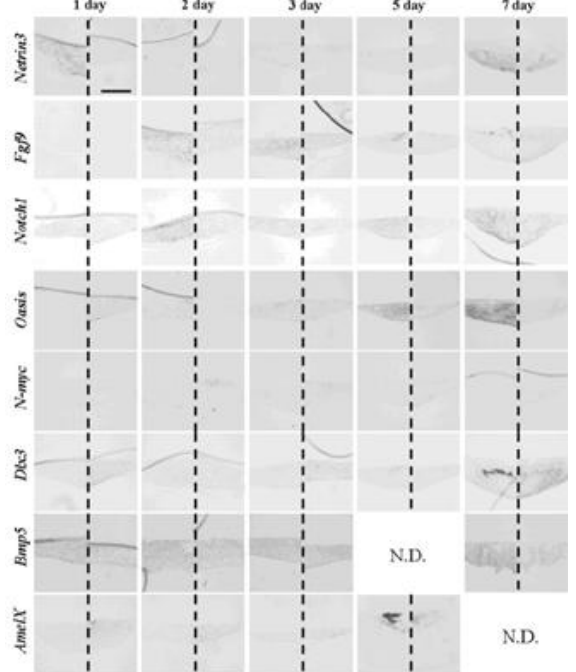
Figure 9. Gene expression pattern in germs reconstructed with emtg-2 cells and EC (1:0.5) and MT. Gene expressions were examined with in-situ hybridization with anti-sense probe in left and sense probe in right of each panel. Germs were cultured on inserts for one to seven